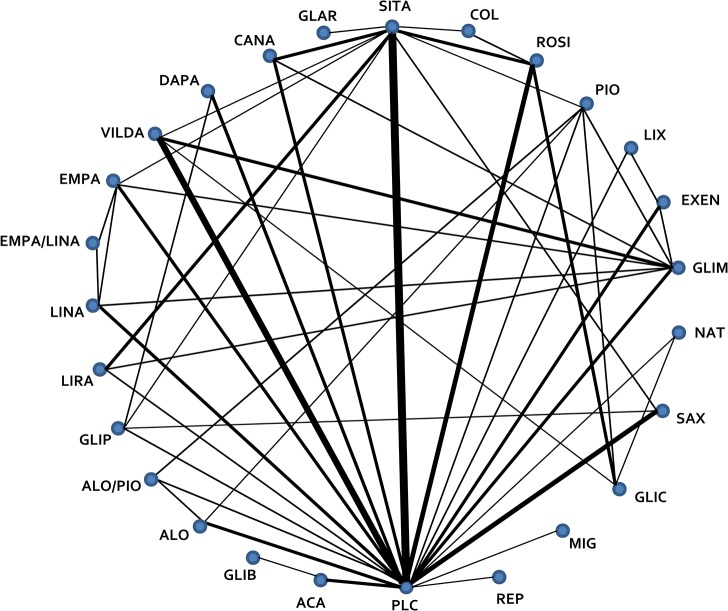
Network Diagram of Randomized Controlled Trials Evaluating Antidiabetic Therapies in Addition to Optimized Metformin in Type 2 Diabetes.All agents are in combination with optimized metformin and include oral and subcutaneous agents and long-acting, once daily basal insulins. Lines represent the presence of direct comparison trial(s). The width of the line is proportional to the number of trials with direct comparisons. ACA, acarbose; ALO, alogliptin; ALO/PIO, alogliptin/pioglitazone; CANA, canagliflozin; COL, colesevelam; DAPA, dapagliflozin; EMPA, empagliflozin; EMPA/LINA, empagliflozin/linagliptin; EXEN, exenatide; GLAR, insulin glargine; GLIB, glibenclamide; GLIC, gliclazide; GLIM, glimeperide; GLIP, glipizide; LINA, linagliptin; LIRA, liraglutide; LIX, lixisenatide; MIG, miglitol; NAT, nateglinide; PIO, pioglitizone; PLC, placebo; REP, repaglinide; ROSI, rosiglitizone; SAX, saxagliptin; SITA, sitagliptin; VILDA, vildagliptin